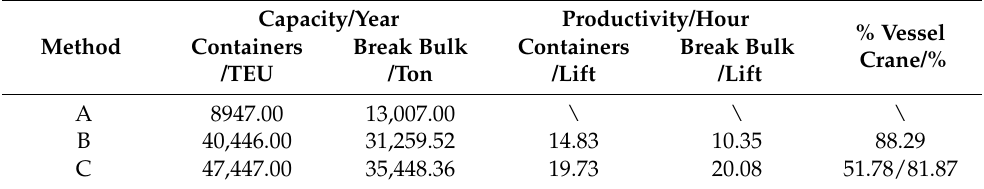
Table 4. Comparison of handling